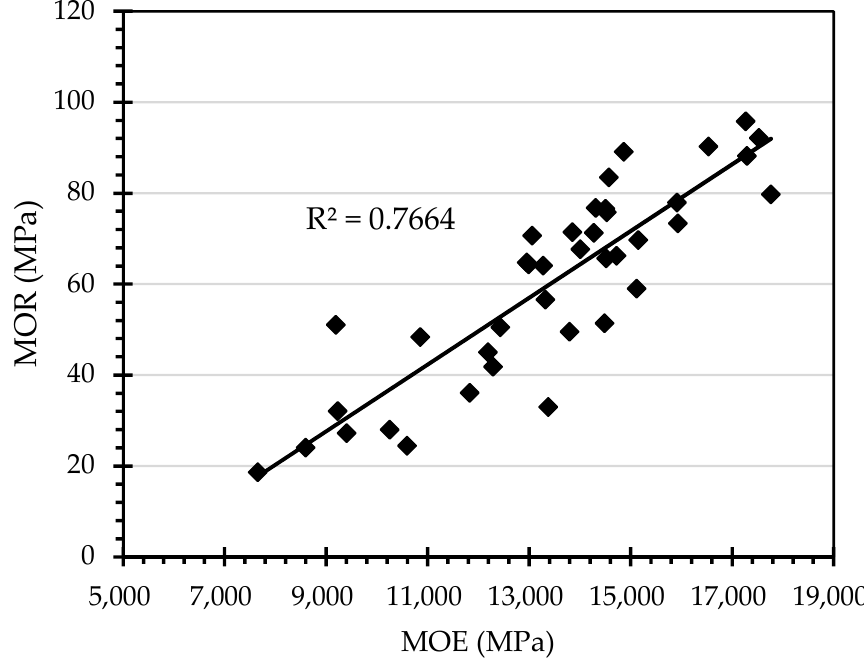
Figure 8. MOE versus MOR values of tested boards .